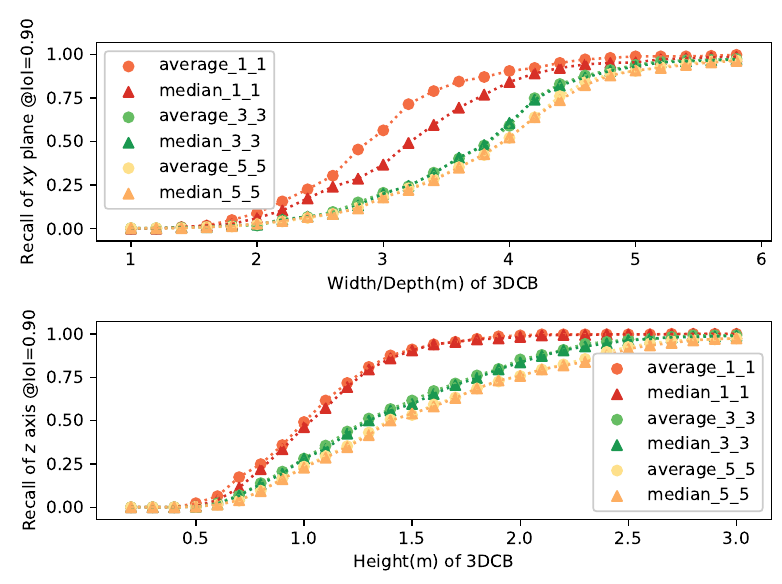
Figure 4. IoI XY and IoI Z with the widths/depths and heights. 3D cropped boxes (3DCBs) are generated from average/median center based on FR × FC subfrustums with different widths/depths and heights. In this plot, verage/median_m_n corresponds to recall based on average/median center in m × n subfrustums.